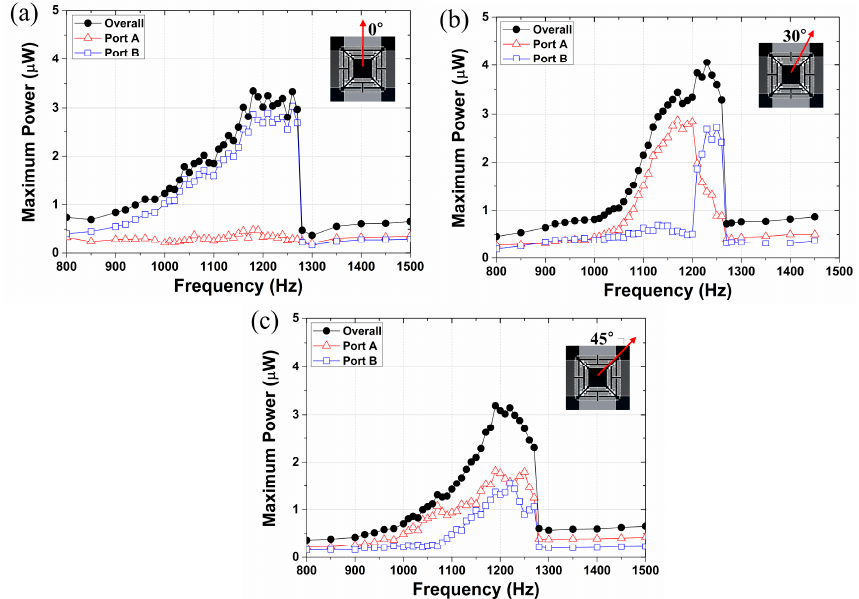
Figure 7. Experimental results for multi-directional energy harvester, exhibiting power generation at ( a ) 0°; ( b ) 30°; and ( c ) 90° input